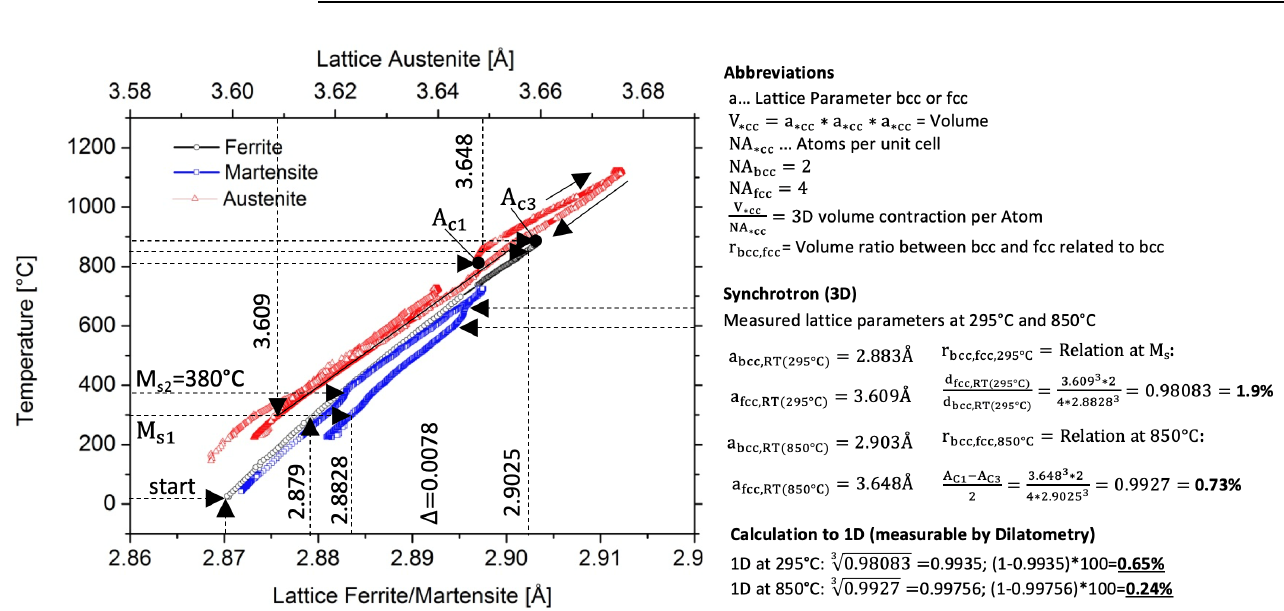
Figure A1. Shows the evolution of the lattice parameters for fcc and bcc (bct) during the in situ synchrotron experiment with the calculated volumetric expansion and relaxation in 3D and 1D for